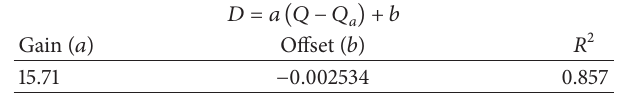
Table 2: Parameters of the lineal fit which correlates relative cooling rate and depth.